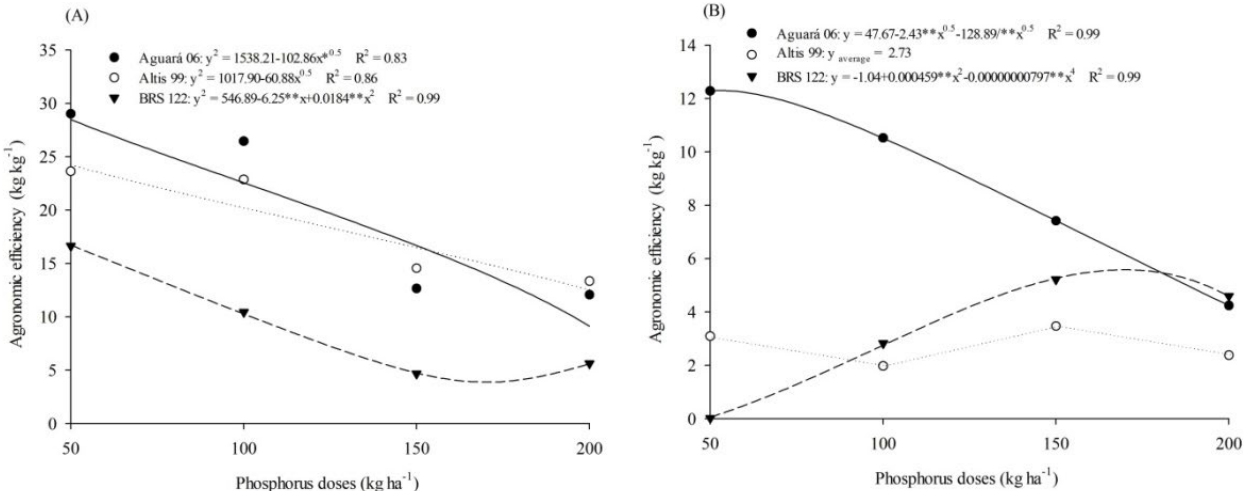
Figure 5. Agronomic efficiency of sunflower as a function of phosphorus doses in the 2016 agricultural harvest ( A ) and 2017 agricultural harvest ( B ).